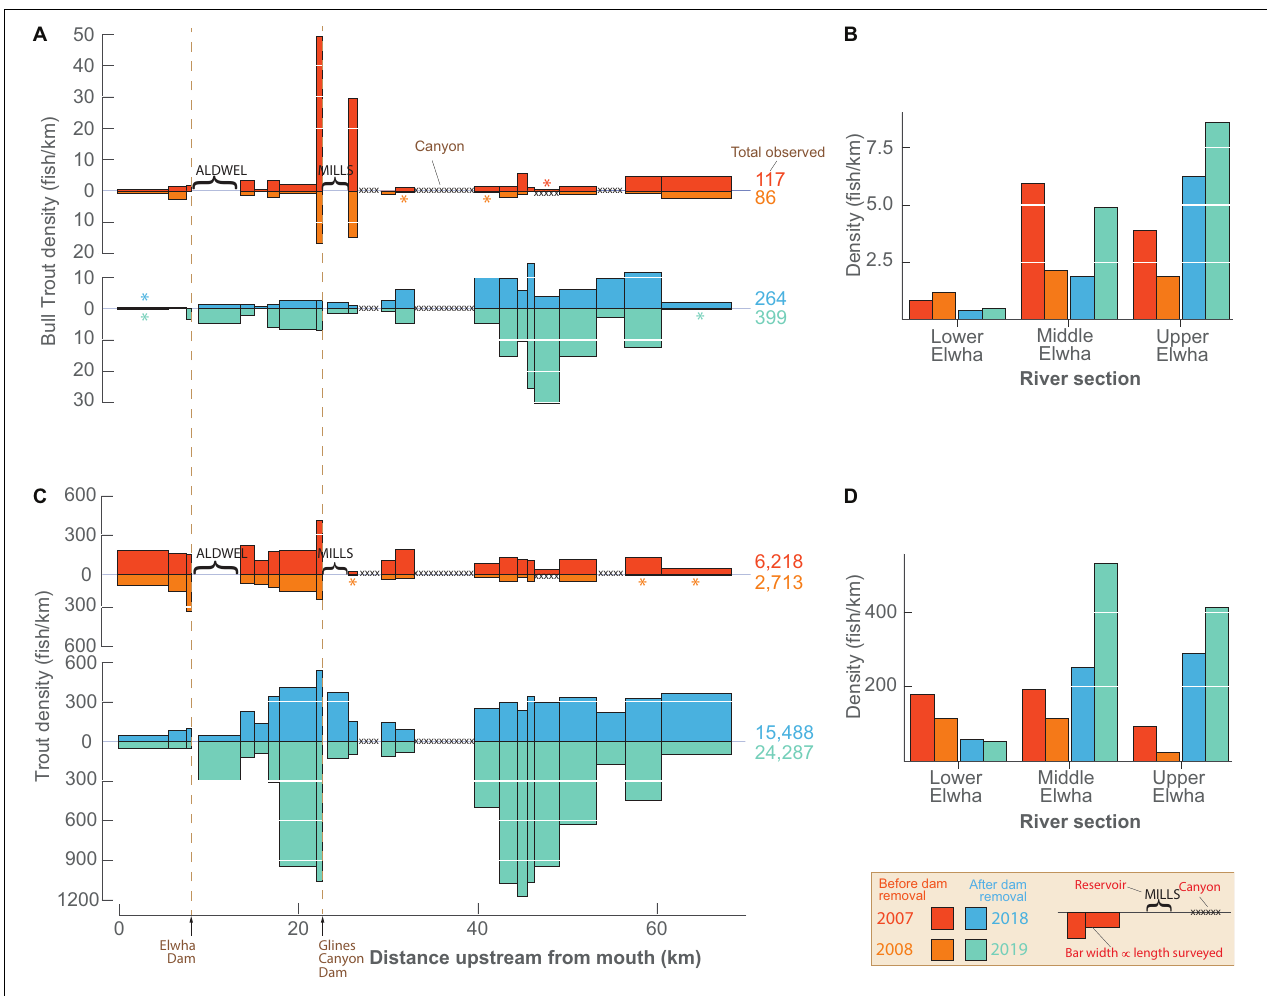
FIGURE 3 | Snorkeling survey results showing the density (number/km surveyed) of Bull Trout and trout ( Oncorhynchus spp. including Rainbow Trout and Coastal Cutthroat Trout) observed during four annual riverscape surveys. Densities are shown for reaches (A,C) and river sections (B,D) , with demarcations of reaches and sections shown in Figure 1 . The 2007 and 2008 surveys (warm colors) occurred prior to dam removal and the 2018 and 2019 surveys (cool colors) occurred after most dam removal effects (e.g., sediment release, turbidity, channel geomorphology; Ritchie et al., 2018) had dissipated. The start and end locations of each river section were standardized across surveys (see section “Common reaches across the four survey years”) and the width of each bar is proportional to the length of the survey measured in the field. Unsurveyed reservoir and canyon sections are indicated by labels and cross-hatch, respectively. Asterisks above and below bars indicate very low densities ( > 0) that are not clearly visible due to the scale of the y -axis.